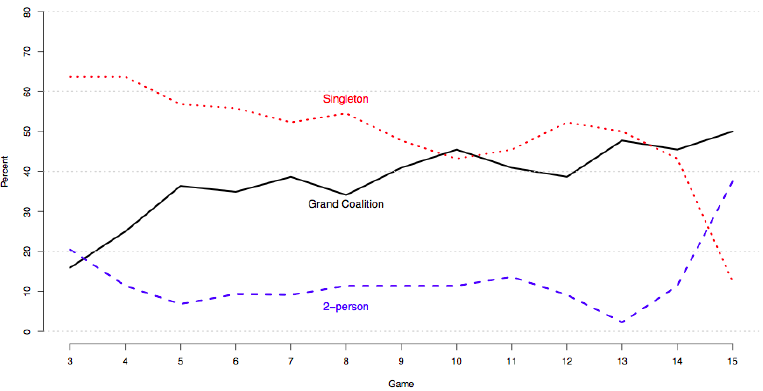
Figure 2. Percentage of final coalitions through games, by type. The percentages are computed over all sessions per game.